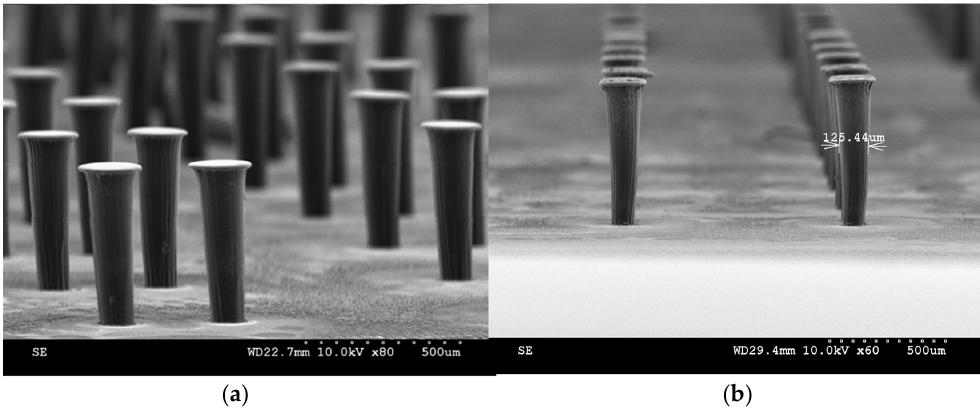
Figure 5. SU-8 3D hair cell structure fabrication: ( a ) and ( b ) show SEM images of arrays of SU-8 hair cells.